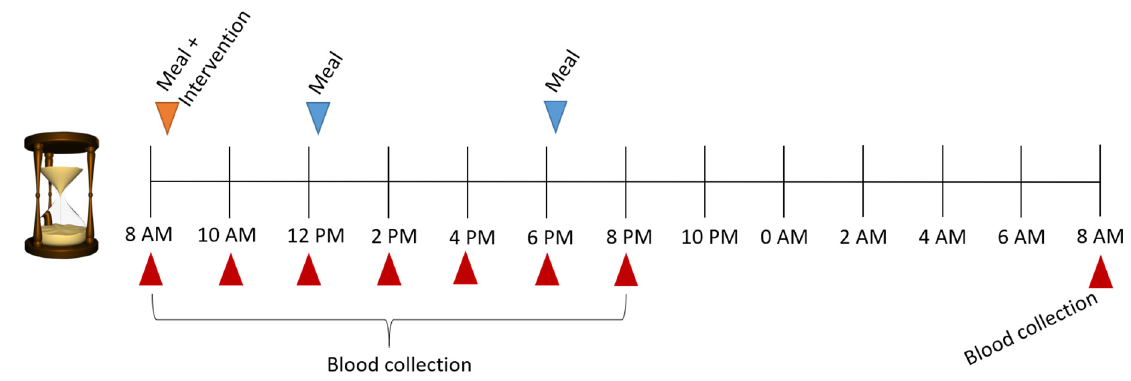
Figure 4. Study day